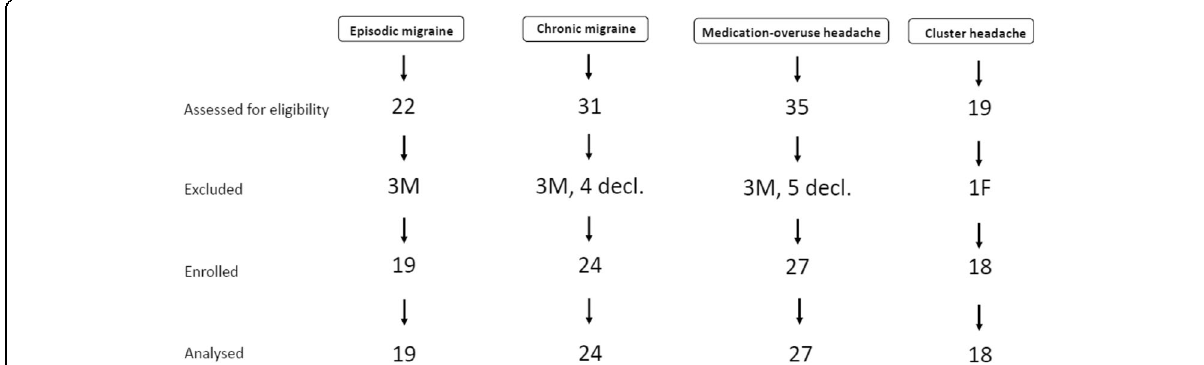
Fig. 1 CONSORT flow diagram of the study (M=males; F=female; decl. =